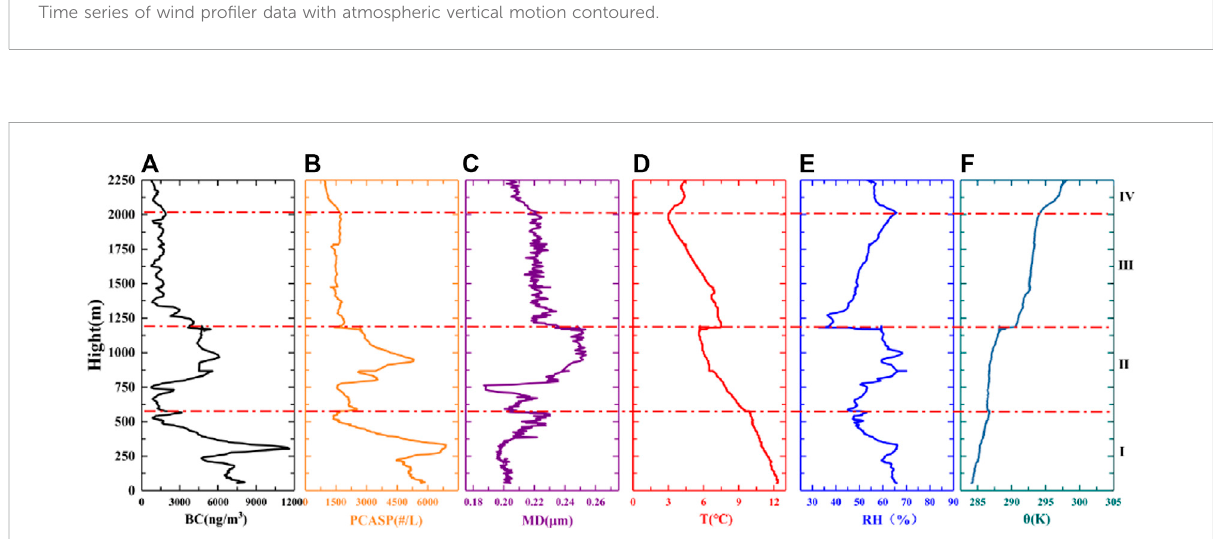
The vertical distribution of BC mass concentration, aerosol number concentration, mean diameter of aerosols, temperature, relative humidity, and the potential temperature was presented in Figure 6. According to the ə θ / ə z , we de fi ned four layers including ground to 600 m, 600 – 1,200 m, 1,200 – 2,000 m, and 2,000 m above (labeled from Ⅰ to Ⅳ in Figure 6). For all four layers, the number of ə θ / ə z was positive with little variation. During this period, the vertical velocity was less than 1 m/s (Figure 5). All four layers were stable with weak atmospheric convection. Two thermal inversion layers were 1,150 – 1230m and 2,000 – 2,300 m, where the 1,150 – 1230 m layer was stronger with a variation of 2.7 ° C/100 m.